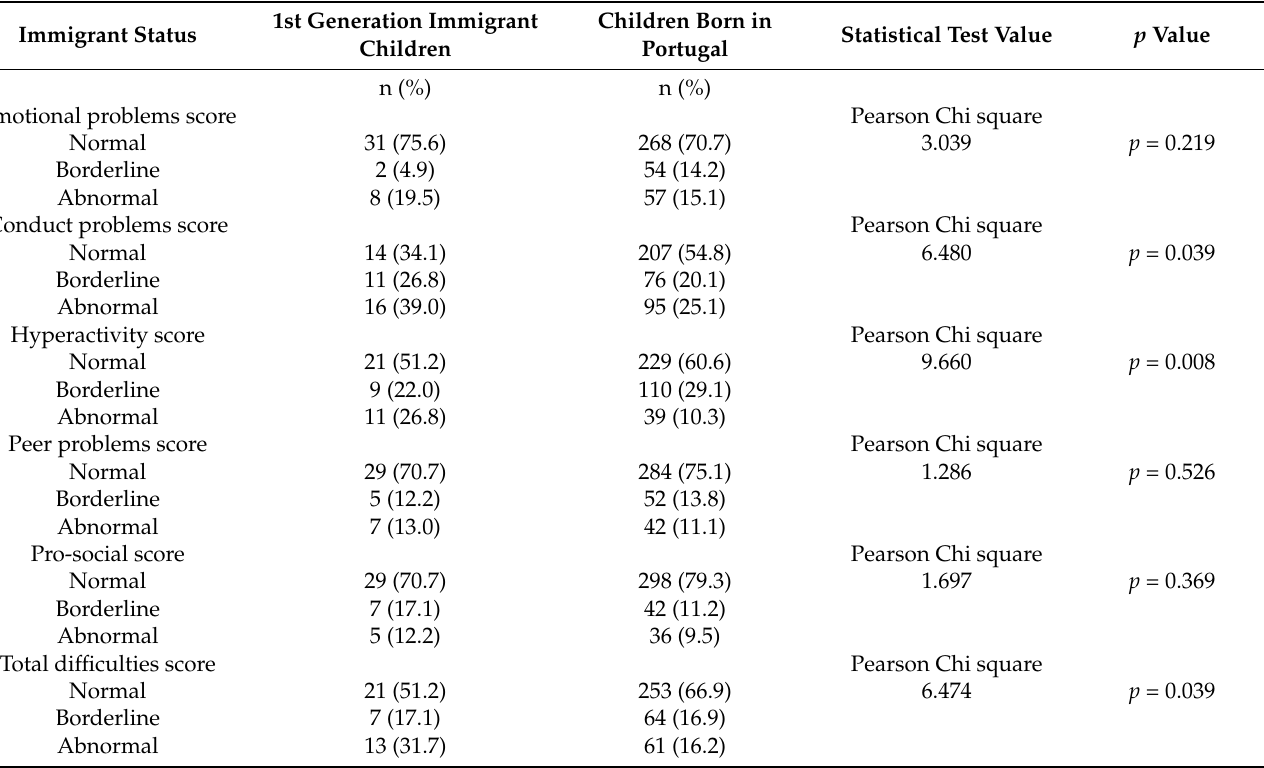
Table 4. Strengths and Difficulties (SDQ) Scores: comparing immigrants with children born in Portugal to Portuguese parents.